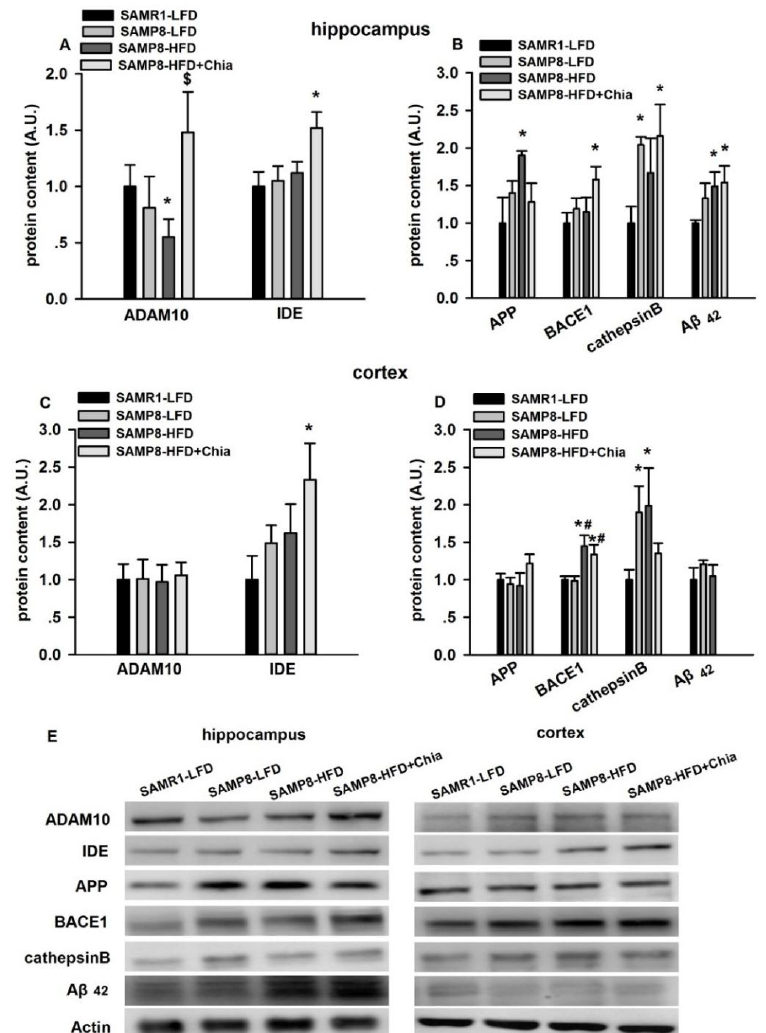
Figure 4. ADAM10, insulin degrading enzyme (IDE), amyloid precursor protein (APP), BACE1, cathepsin B and A β 42 protein expression in the hippocampus and cortex. Protein expression of ADAM10, IDE, APP, BACE1, cathepsin B and A β 42 in the hippocampus ( A , B ) and cortex ( C , D ) from all groups measured via Western blotting. Representative blots are shown in panel ( E ). A.U. means arbitrary units. Data are presented as means + SEM for 8 mice per group. * p < 0.05 versus SAMR1-LFD group. # p < 0.05 versus SAMP8-LFDgroup. $ p < 0.05 versus P8HF